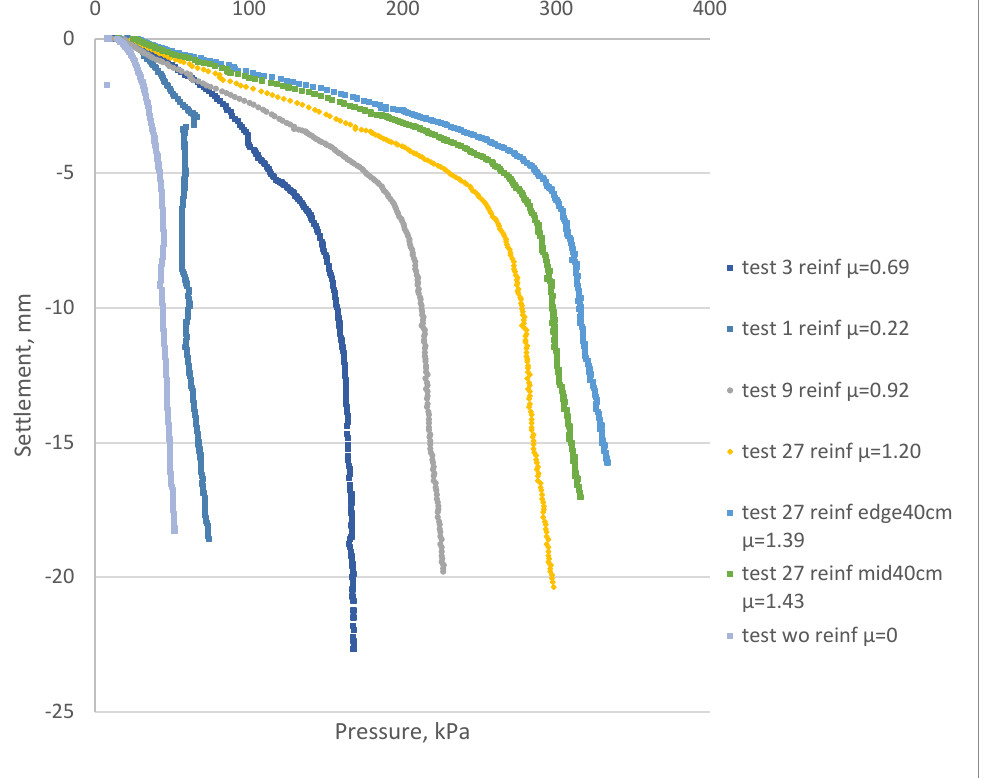
Figure 7. Load − settlement curves for the tested samples before and after the reinforcement process. Reference samples without reinforcement correspond to “test wo reinf µ = 0”. The legend specifies the number of reinforcing elements: 1, 3, 9 or 27 reinf. Elements with 40 cm extended lengths at the edges (sample No 6) or at the middle (sample No 7) are specified as “edge 40 cm” or “mid40 cm” accordingly.